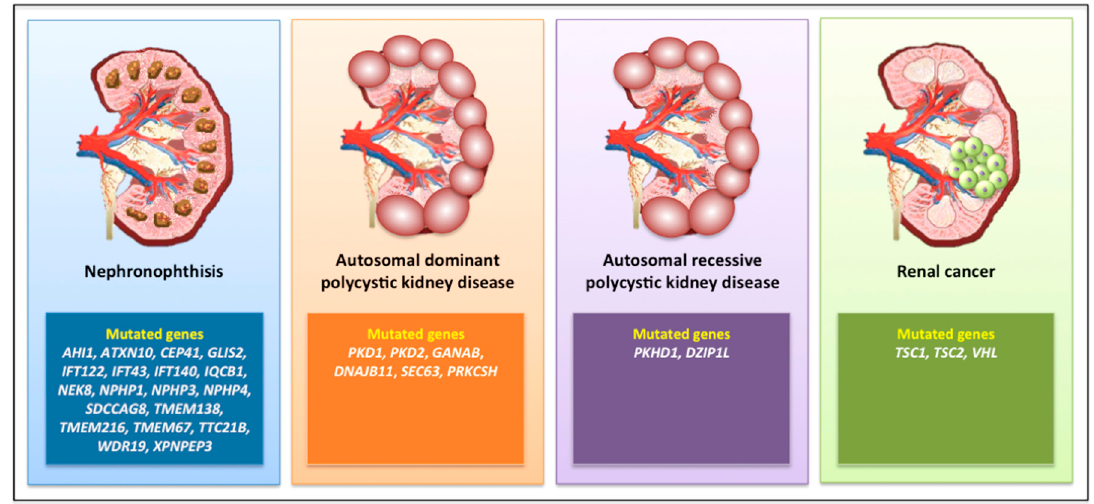
Figure 2. A selection of gene mutations associated with the development of renal ciliopathies.